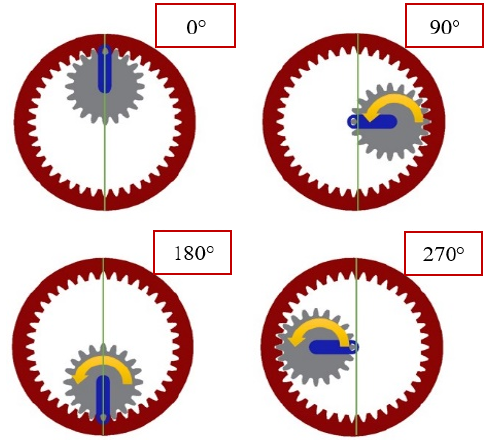
Figure 11. Principle of operation of a hypocycloidal drive [41].